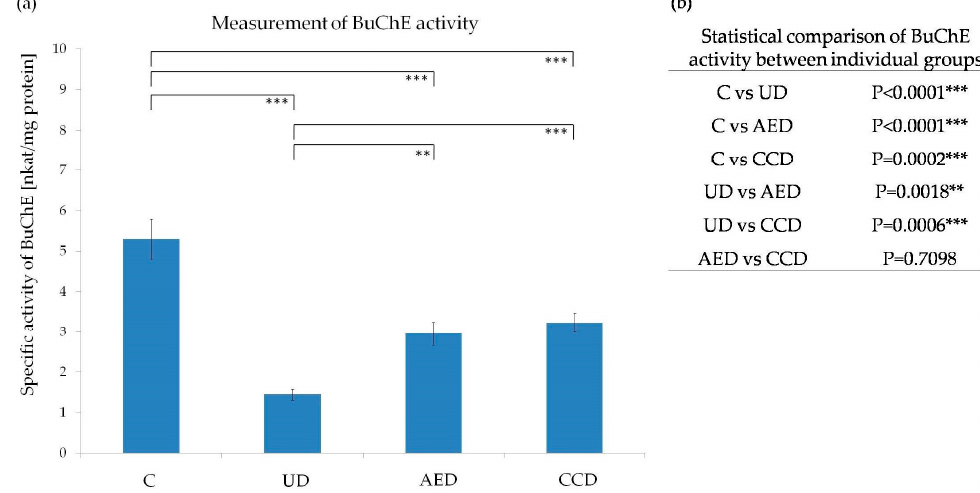
Figure 4. ( a ) Effect of A. eupatoria and C. cardunculus on specific activity of BuChE in rat livers; ( b ) Statistical comparison of BuChE activity between individual groups (C—control group,